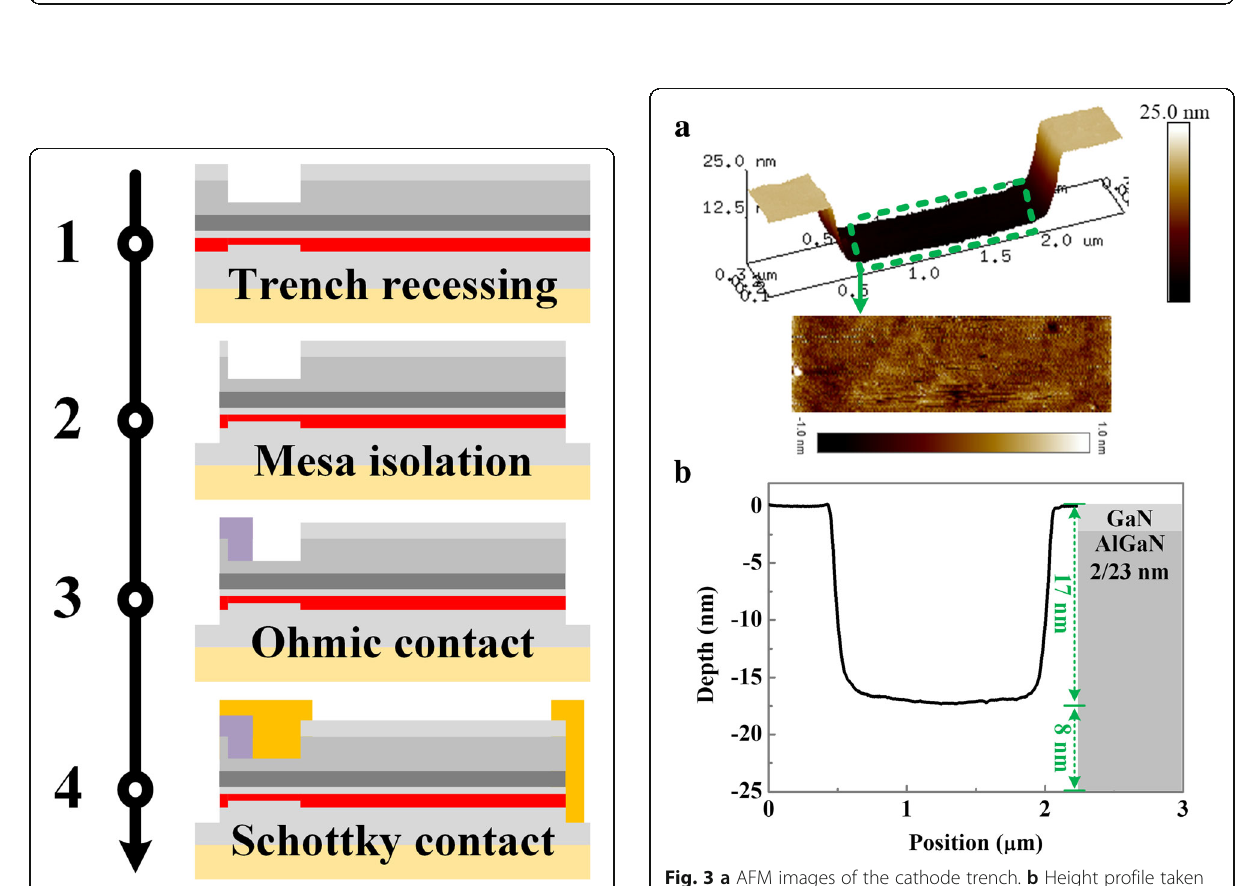
Fig. 1 a Schematic cross section of the RB-CRD. b Circuit diagram of battery charging using the RB-CRD